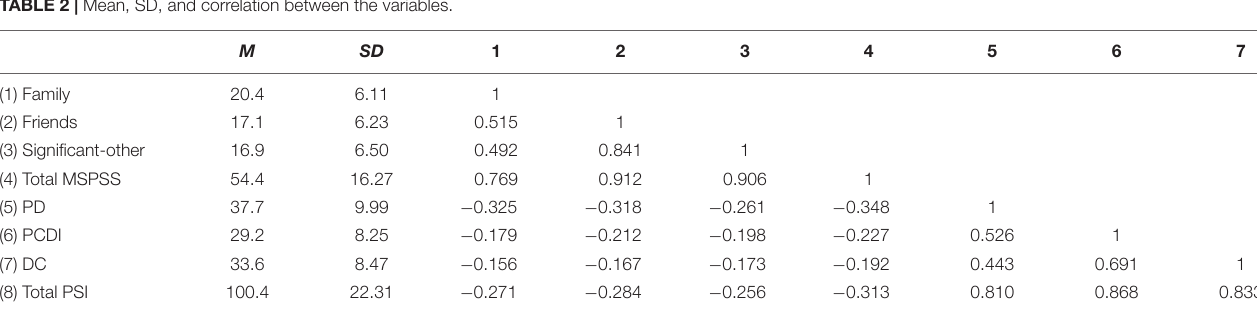
TABLE 2 | Mean, SD, and correlation between the